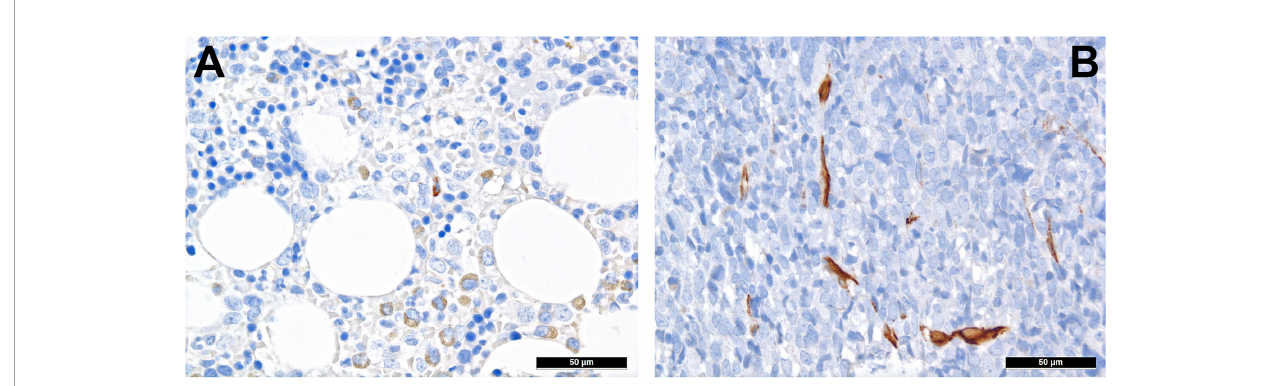
FIGURE 1 | Distribution of nestin+ cells of the perivascular niches in AML. (A) Nestin expression in MSC-equivalents in normal bone marrow (immunohistochemistry, 400x); (B) Increased presence of nestin-positive MSC-equivalents in a case of AML suggesting importance of the former cells for AML survival (immunohistochemistry,